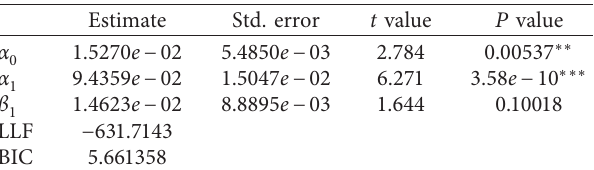
Table 4: Estimated coefficients of the GARCH(1,1) model for